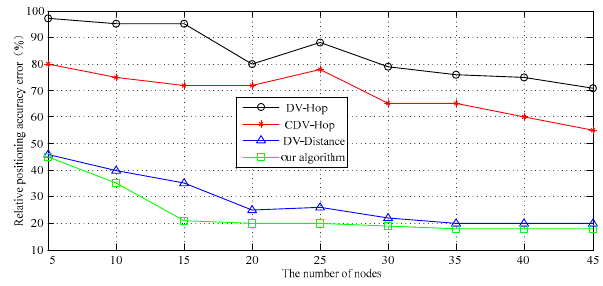
Figure 11. Localization error vs. Total number of sensor nodes.